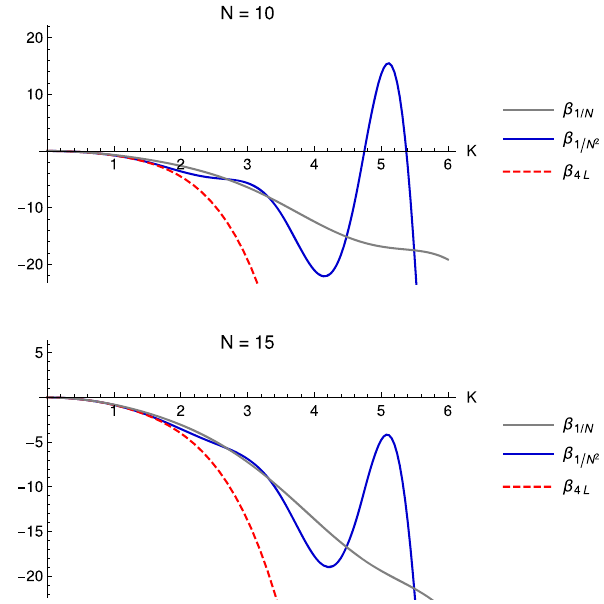
Fig. 1 The β -function of Eq. (10) truncated to O ( 1 / N ) , β 1 / N , and to O ( 1 / N 2 ) , β 1 / N 2 along with the four-loop perturbative result, function of the rescaled coupling K = gN for N = 10 ,